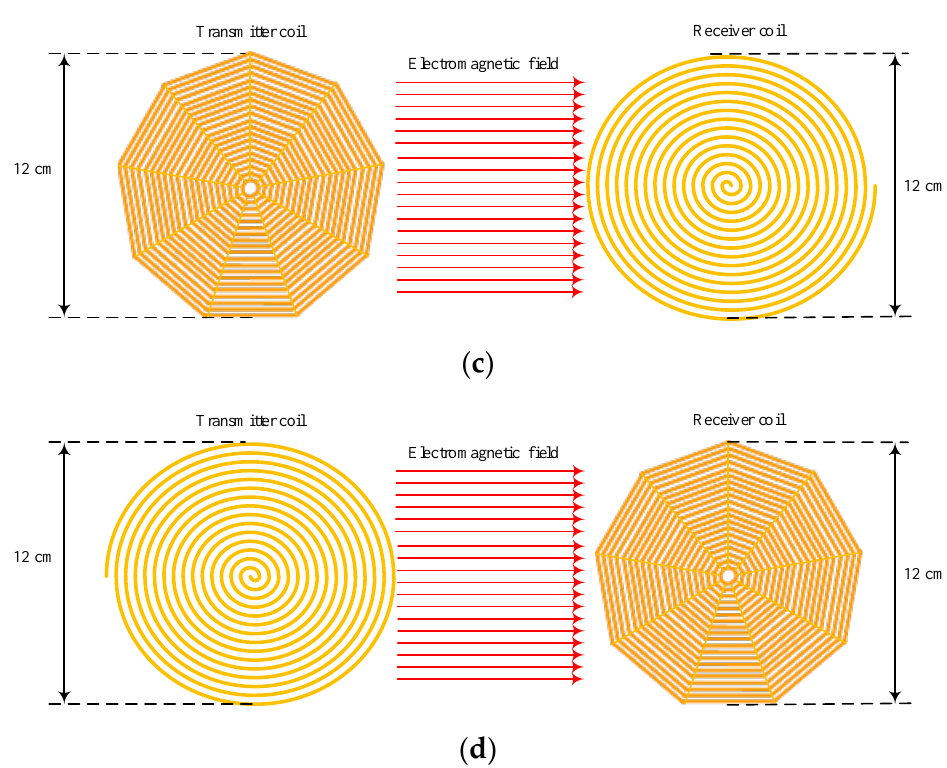
Figure 1. Coils topologies ( a ) spiral-spiral, ( b ) spider-spider, ( c ) spider-spiral, and ( d ) spiral-spider. The spiral and spider coils parameters are presented in Table 2. The oscillator in the transmitter unit generates a frequency of 13.5 kHz, and the inductance of the spiral and spider coils are 695 and 720 µ H. Therefore, the resonance capacitors can be connected in parallel with the coils, can be computed based on Equation (1) to transfer maximum power from the transmitter coil to the receiver coil at resonant frequency ( f 0 ).